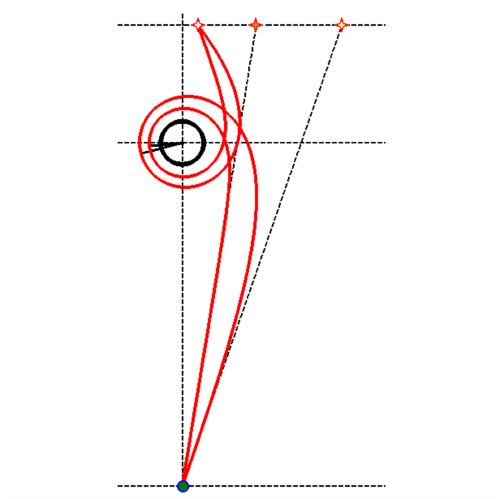
Figure 7. Relativistic images in the case of lensing by black hole surrounded by homogeneous plasma. Two images and corresponding light rays of different wavelengths are